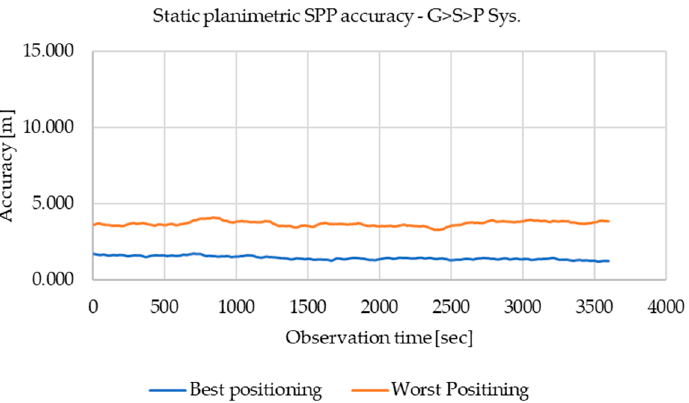
Figure 11. Accuracy (best and worst) in real-time static planimetric SPP of the G > S > P Sys during 3600 s.